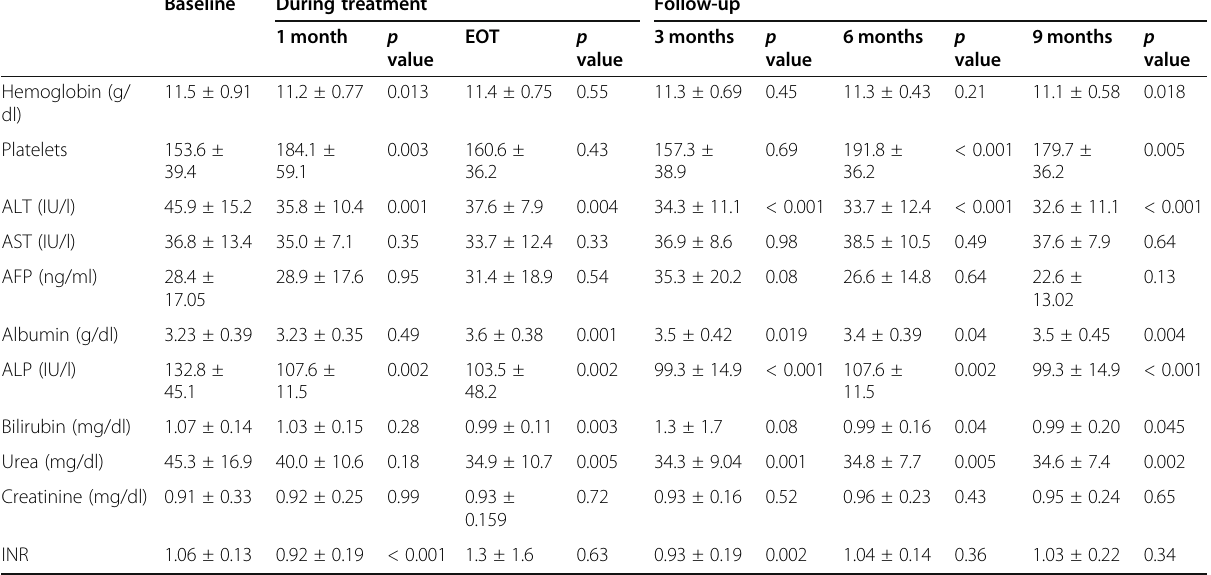
Table 1 Comparison between baseline and follow-up values of lab investigations of patients Baseline During treatment